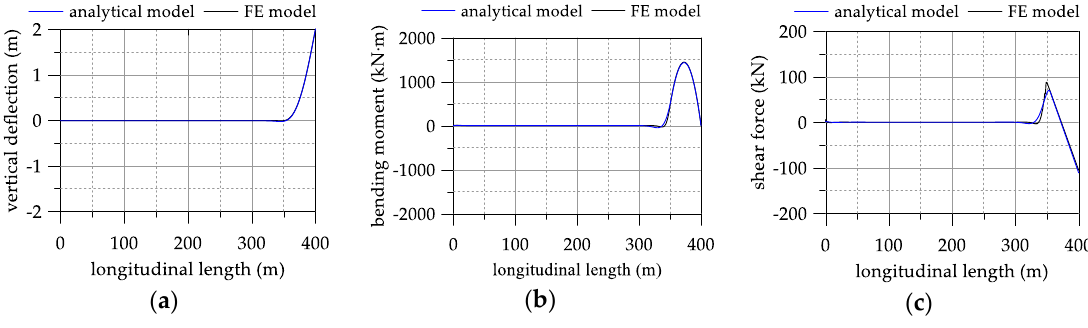
Figure 8. Comparison of Model 1 to the FE analysis results during lowering-in: ( a ) deflection; ( b ) bending moment; ( c ) shear force.